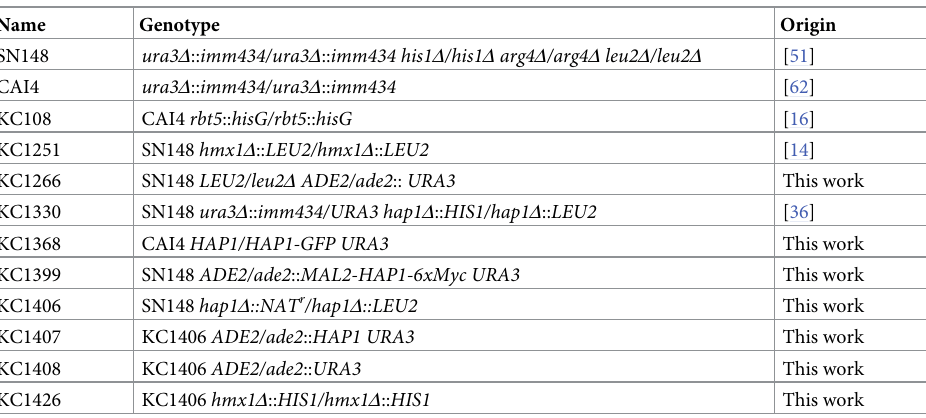
Table 4. List of Candida albicans strains.